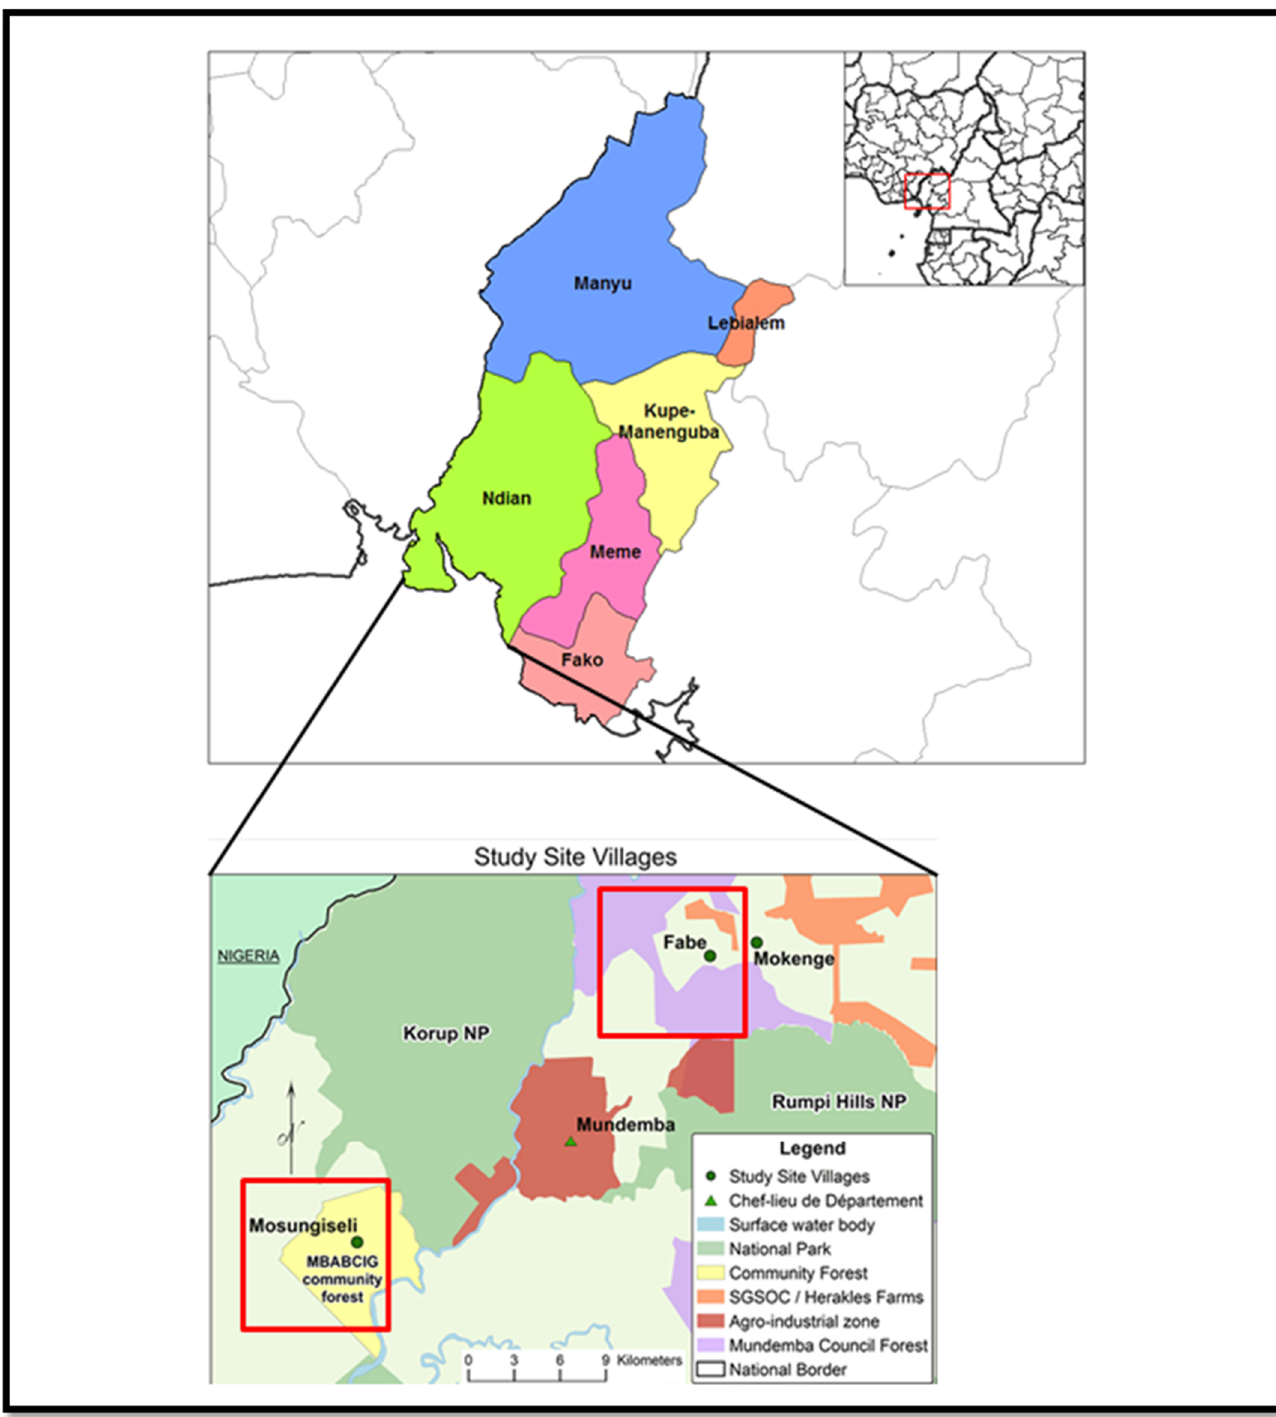
Figure 2. Study Site Villages . Source: Adapted from Refs. [34,35].